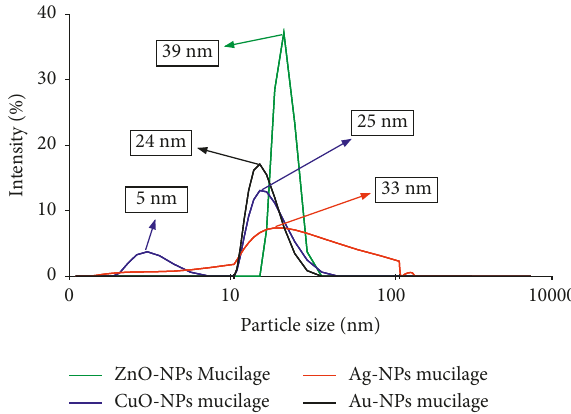
Figure 1: Size distribution of green synthesized nanoparticles of date palm mucilage. Table 1: Flow properties of granules of date palm